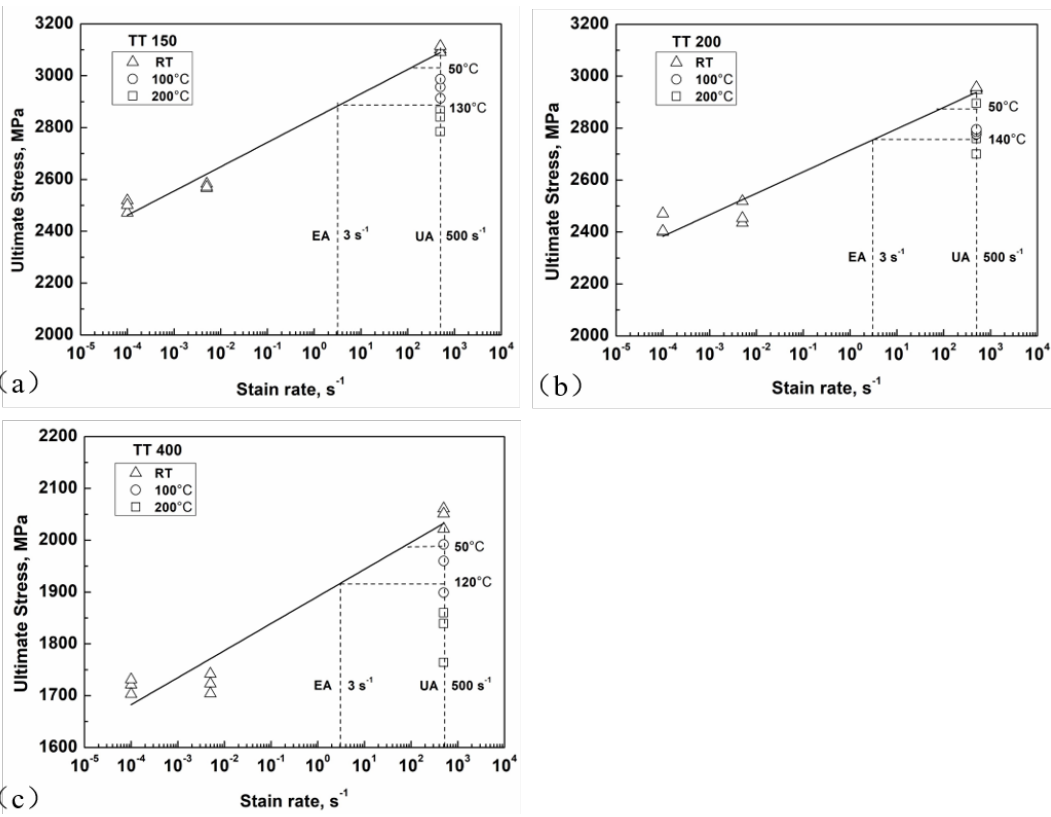
Figure 8. Ultimate stress under different loading strain rates and temperatures for three material conditions: ( a ) TT 150; ( b ) TT 200; ( c ) TT 400. (RT: Room temperature).